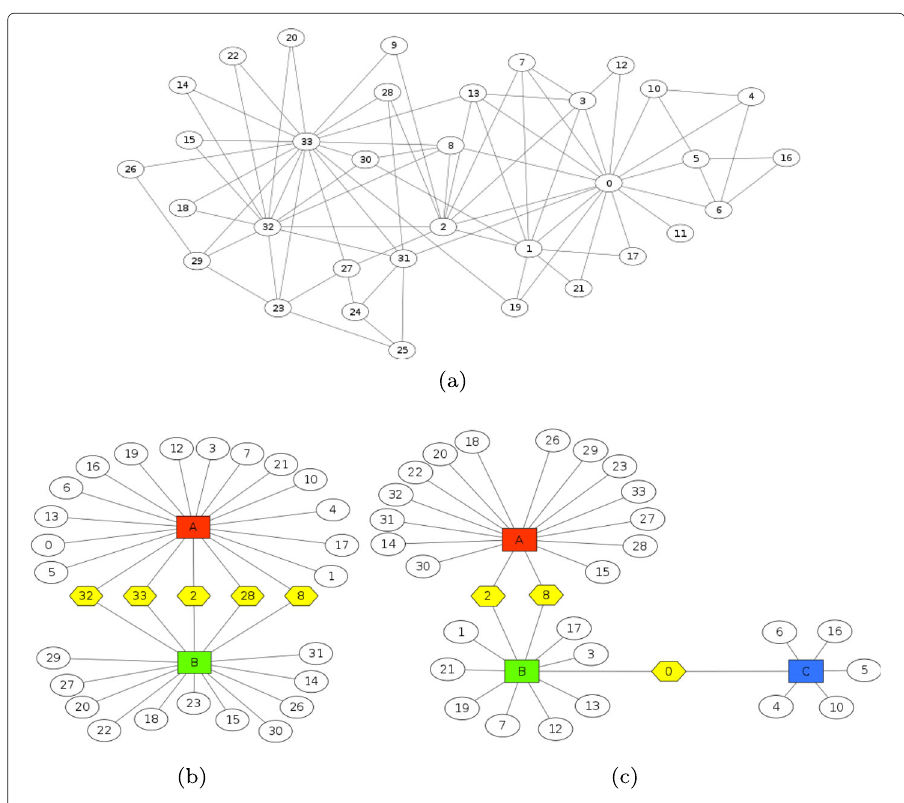
Fig. 2 Zachary Karate Club example. a The Zachary Karate Club network. In ( b - c ) the bipartite graph showing node-community affiliation (colored squares representing communities, yellow hexagons identifying nodes belonging to more than one community). b Clustering for φ = 0.33, ( c ) Clustering for phi =